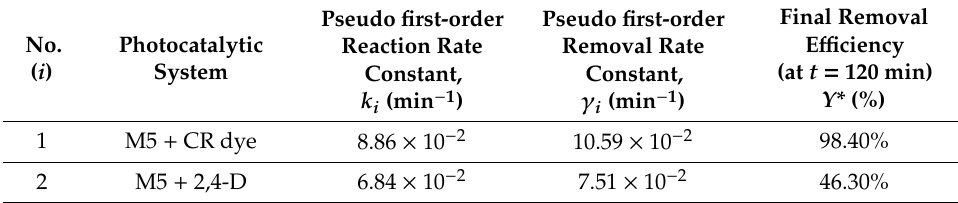
Table 4. Kinetic parameters for Congo-Red dye and 2,4-D photodegradation in the presence of the